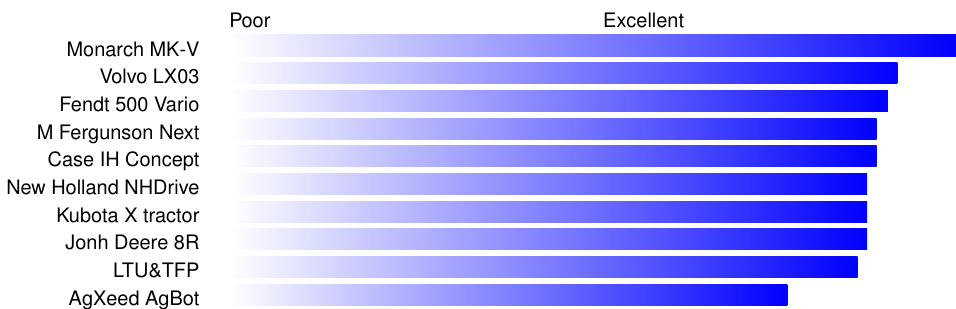
Figure 10. MIM overall evaluation: control, perception and communications